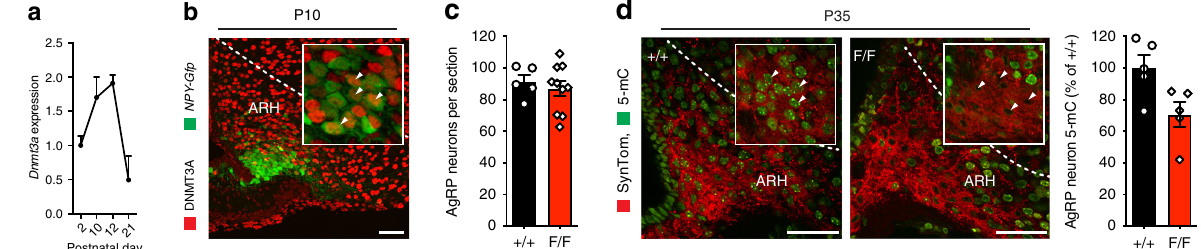
Fig. 1 AgRP neuron-speci fi c knockout of Dnmt3a reduces DNA methylation in AgRP neurons. a Dnmt3a expression peaks in the postnatal ARH at P12 ( n = 5 – 8 per timepoint). b Immunostaining for Dnmt3a shows that AgRP/NPY neurons (labeled by GFP) express Dnmt3a at P10 (inset: 63× confocal image, NPY + ; DNMT3A + neurons indicated by arrow). Scale = 10 μ m. c AgRP neuron-speci fi c Dnmt3a knockout does not affect AgRP neuronal density, t (13) = 0.55, p = 0.59, n = 5 – 8. d Relative to + / + mice, AgRP neurons (labeled by SynTom) of F/F mice show reduced levels of 5-methylcytosine; left — representative immuno fl uorescent labeling of 5-mC in SynTom + AgRP neurons (inset: 63× confocal image, representative AgRP neurons indicated by arrow), right — quantitation of 5-mC labeling intensity in AgRP neurons, t (8) = 2.64, p = 0.03, n = 5. Scale = 10 μ m. Values re fl ect mean±SEM. * p <0.05. Source data for a, c, d are provided as a Source Data fi